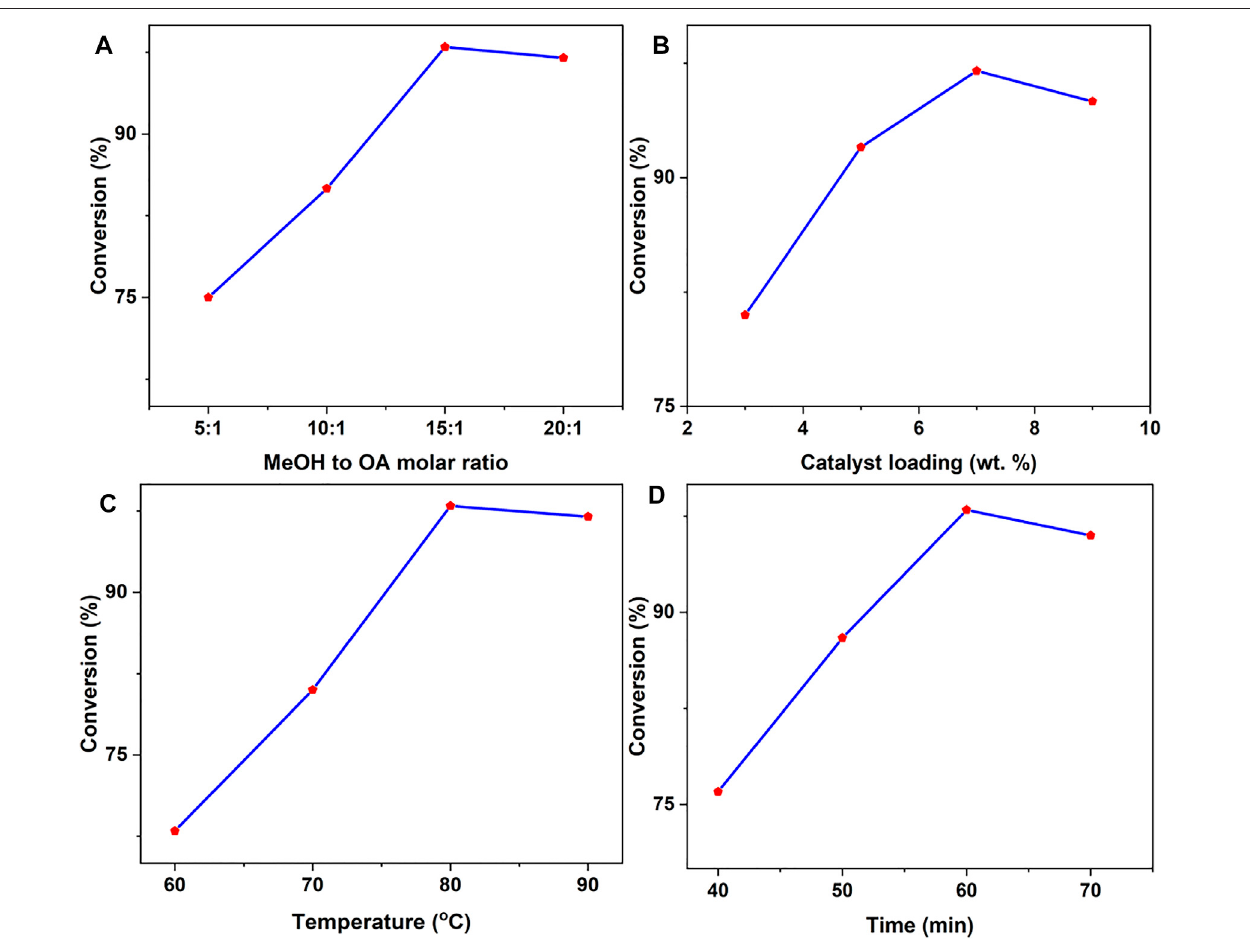
FIGURE 5 | Effects of various factors on oleic acid esteri fi cation. (A) Varying the methanol to OA molar ratio from 5:1 to 20:1 (other conditions: 7 wt.% catalyst loading, 80 ° C reaction temperature, 60 min reaction time). (B) Changing the catalyst loading from 3 to 9 wt.% relative to OA (other conditions: MeOH to OA molar ratio 15:1, 80 ° C reaction temperature, 60 min reaction time). (C) Temperatures ranging from 60 to 90 ° C (other conditions: MeOH to OA molar ratio 15:1, 7 wt.% catalyst loading,60 minreactiontime). (D) Changingthetimefrom40to75 min(alternativeconditions:MeOHtoOAmolarratio15:1,7 wt.%catalystloading,80 ° Creaction temperature).